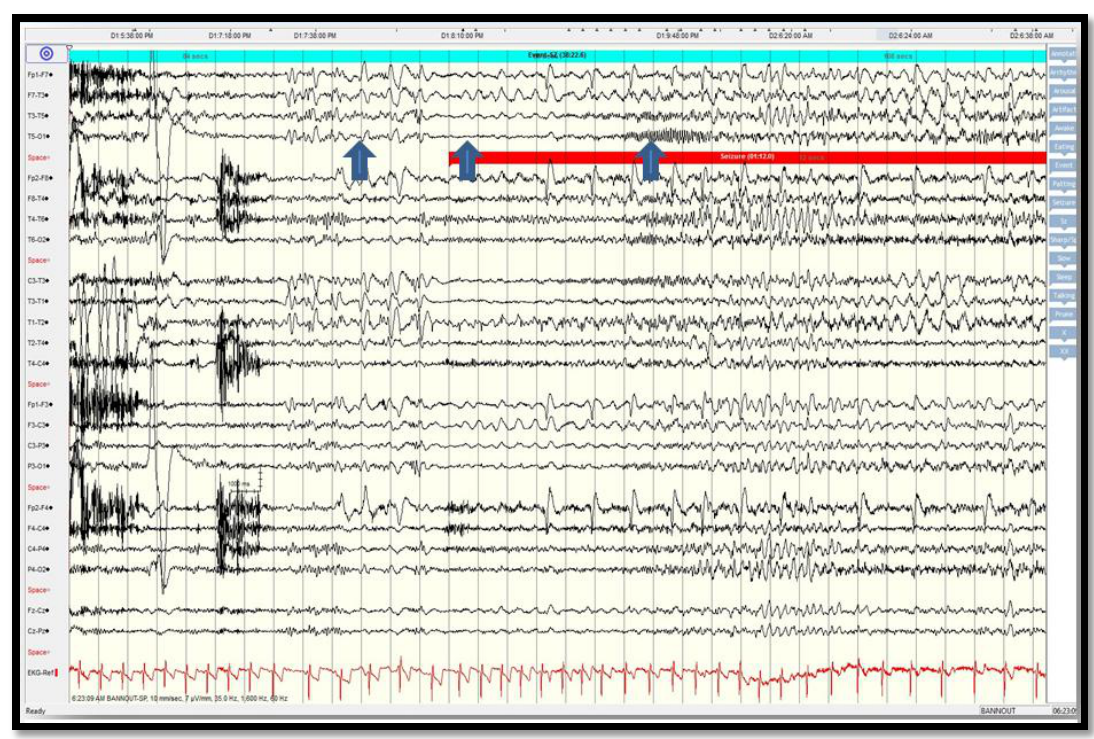
Figure 2. Scalp EEG recording showing broad periodic left fronto-temporal sharp waves (arrow 1 from the left) followed by attenuation at T3/T5 and T3/T1 (arrow 2) then low amplitude rhythmic beta frequencies at T5/O1 (arrow 3).